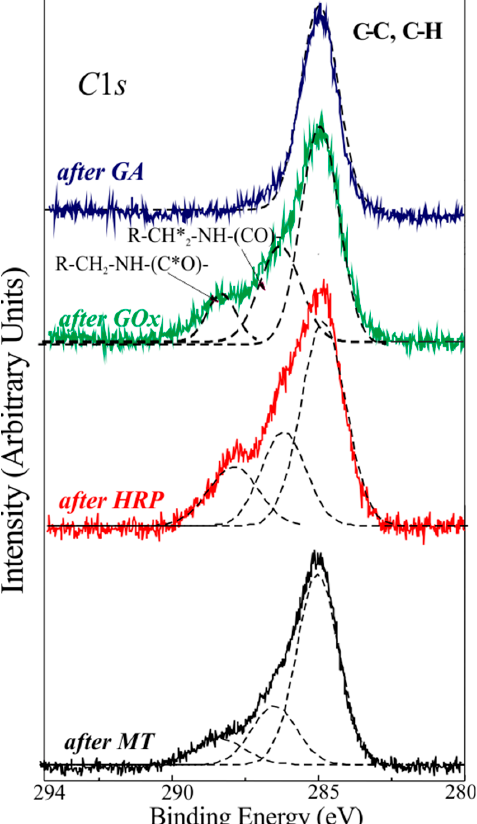
Figure 1. XPS C1s spectral regions of the samples after the various protocol steps: after GA anchoring ( blue line ); after binding of GOx ( green line ), HRP ( red line ) and MT ( black line ) proteins. Simulation of C1s components ( black dashed line ).